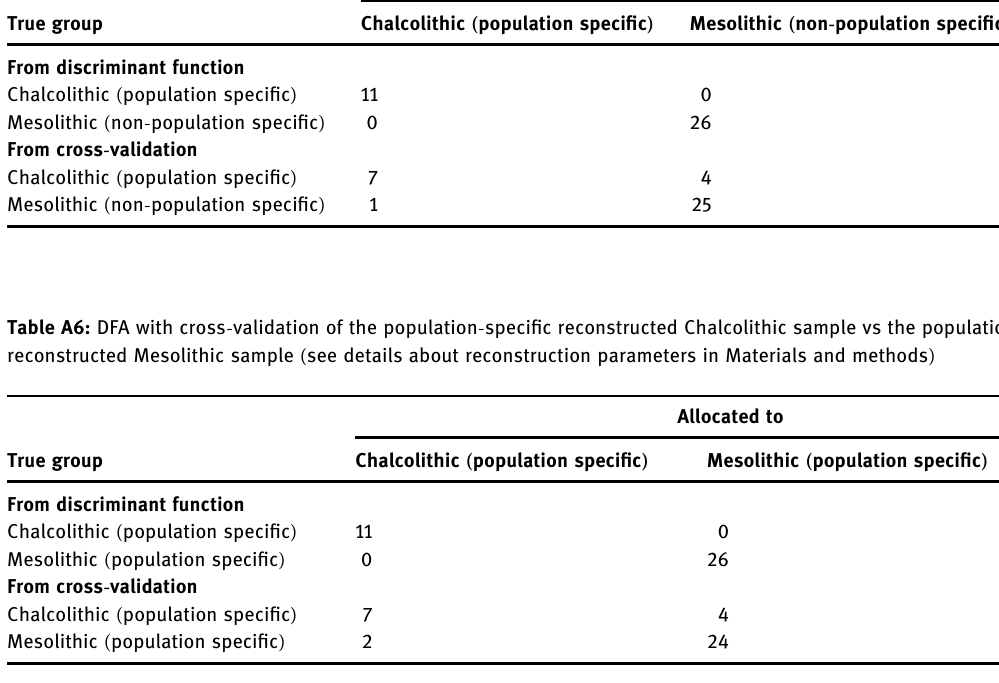
Table A5: DFA with cross - validation of the population - speci fi c reconstructed Chalcolithic sample vs the non - population - speci fi c reconstructed Mesolithic sample ( see details about reconstruction parameters in Materials and Methods )